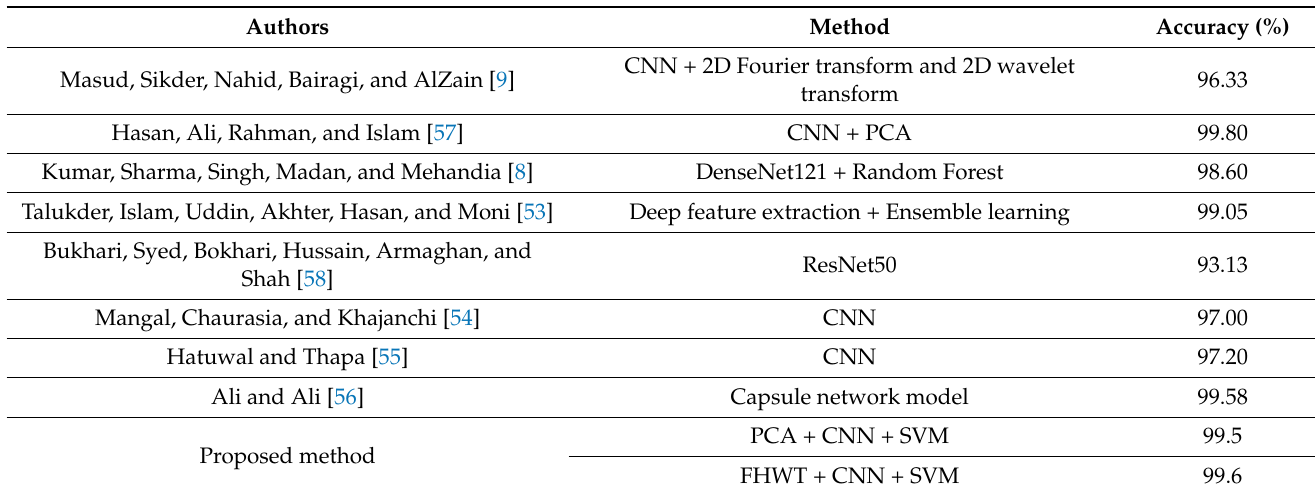
Table 5. Comparative analysis with previous